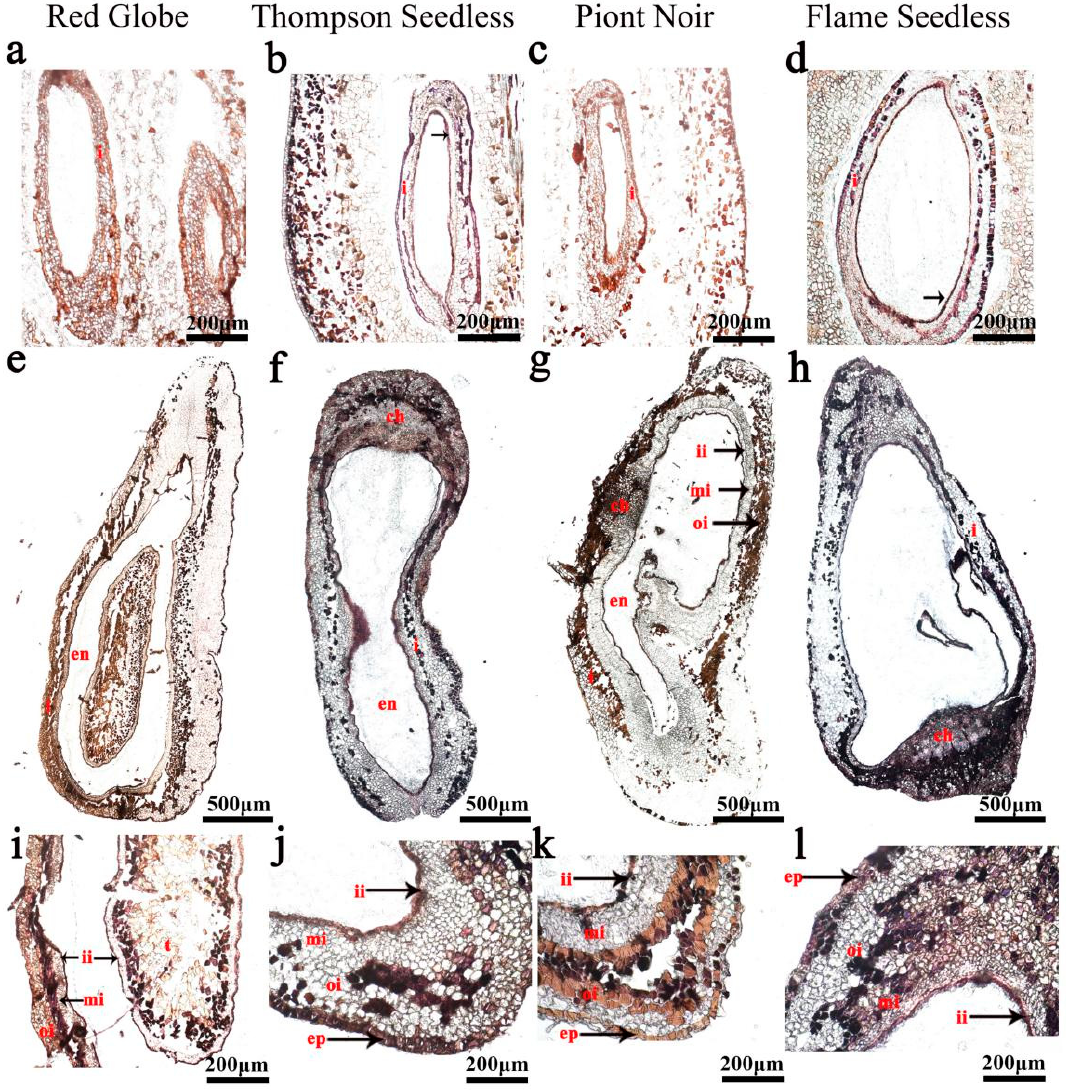
Figure 6. VvHB63 expression analysis in grapevine ovules by in situ hybridisation. ( a – d ): 15 DAF;